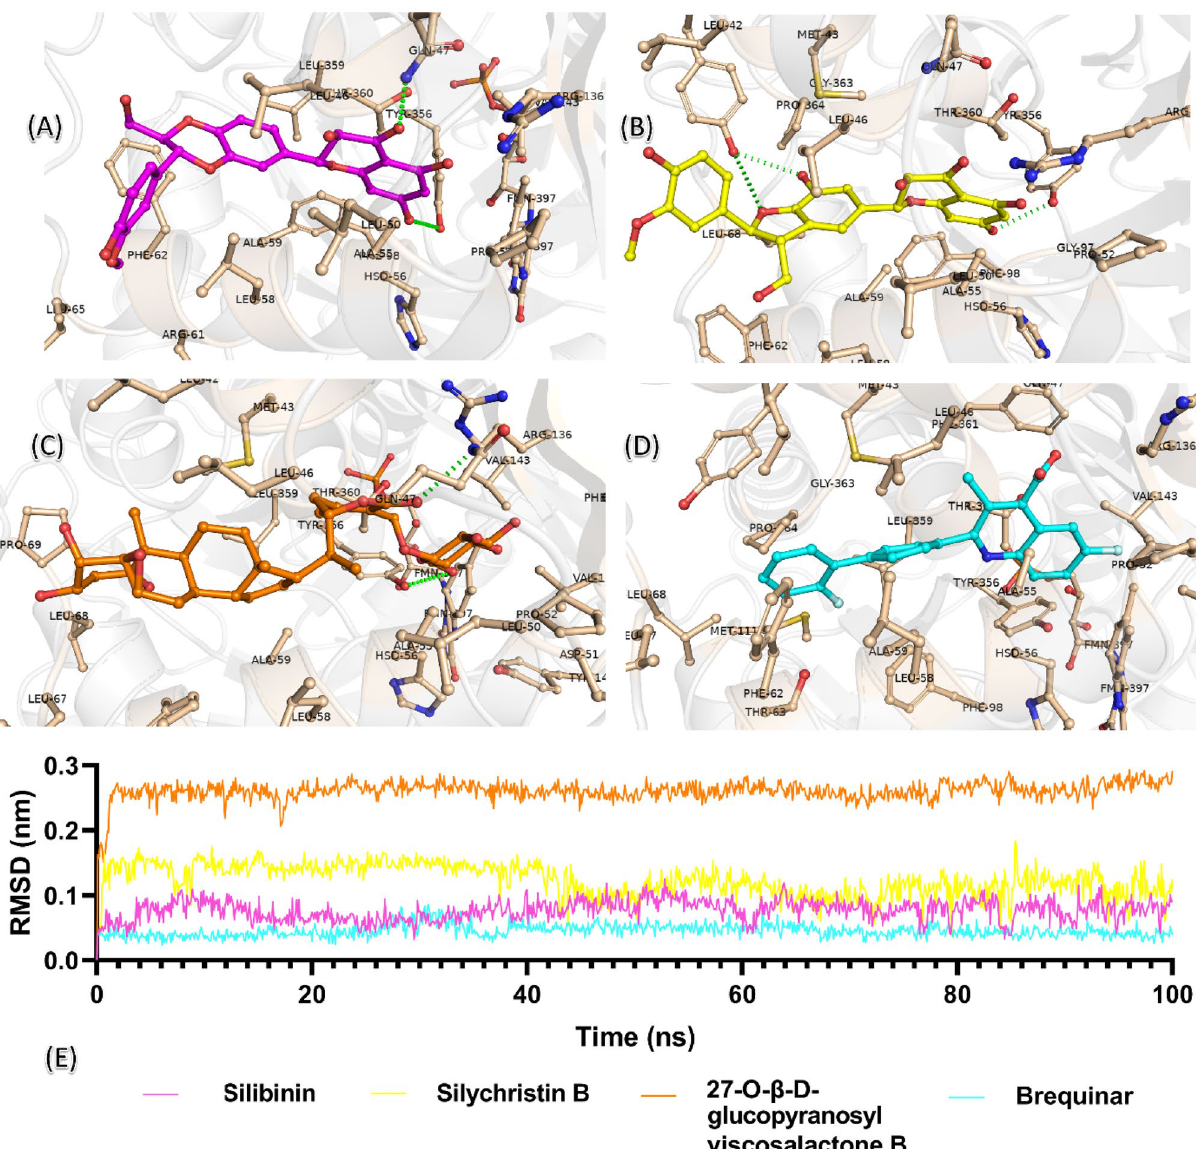
Figure 8. Protein–ligand interactions in molecular dynamics simulation of ( A ) hDHODH & silibinin, ( B ) hDHODH & silychristin B, ( C ) hDHODH & 27- O-β -D-glucopyranosyl viscosalactone B and ( D ) hDHODH & brequinar complexes at the end of 100 ns. ( E ) RMSD of compounds silibinin, silychristin B, 27- O-β -D- glucopyranosyl viscosalactone B and brequinar from the beginning to the end of 100